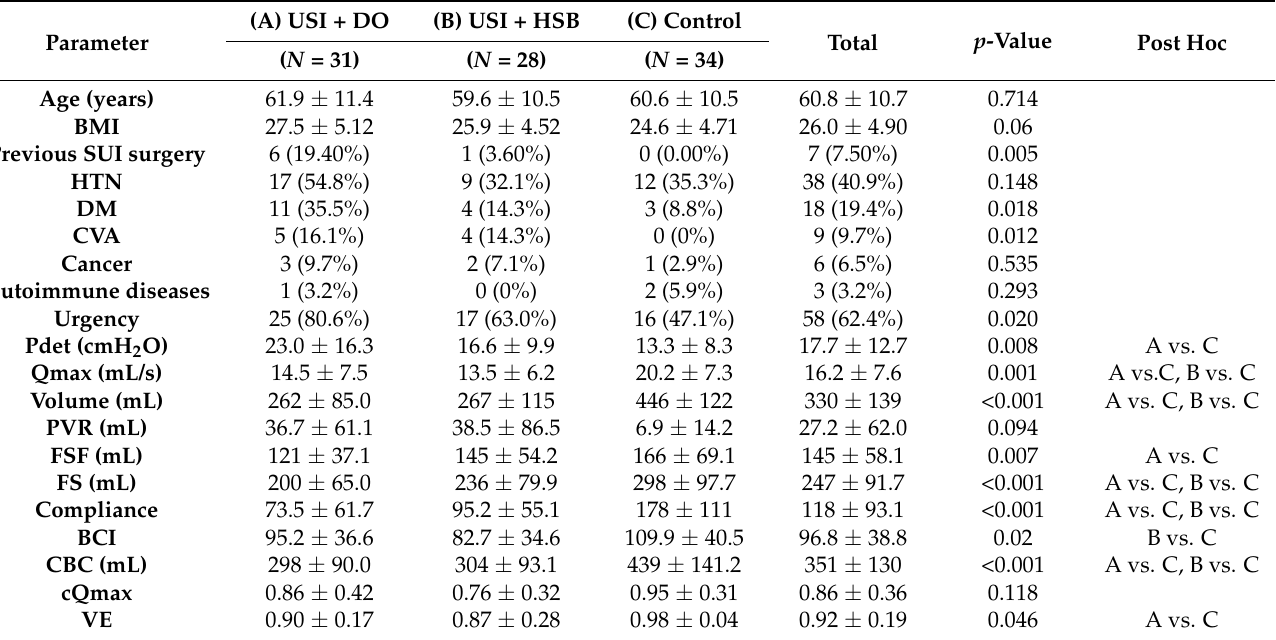
Table 1. Clinical characteristics and urodynamic parameters of the USI and DO, USI and HSB, and control groups (USI and stable